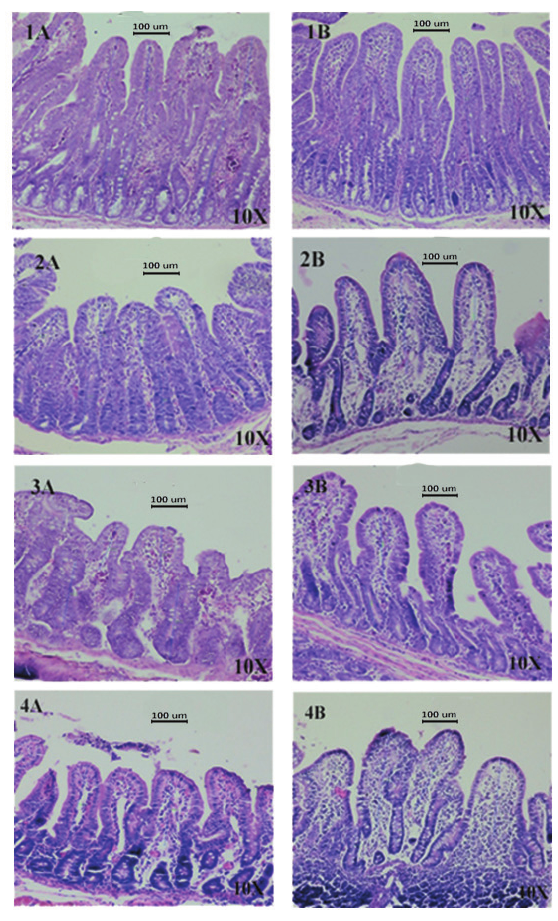
Figure 1. Effect of Lactobacillus salivarius (L. salivarius) on intestinal microscopic morphology (H&E staining) of piglets challenged with Escherichia coli F4. Villus height and crypt depth (μm) were measured using an Isolution lite software version 10.1. (A) control group, (B) L. salivarius group, (1) duodenum, (2) proximal jejunum, (3) distal jejunum, and (4)